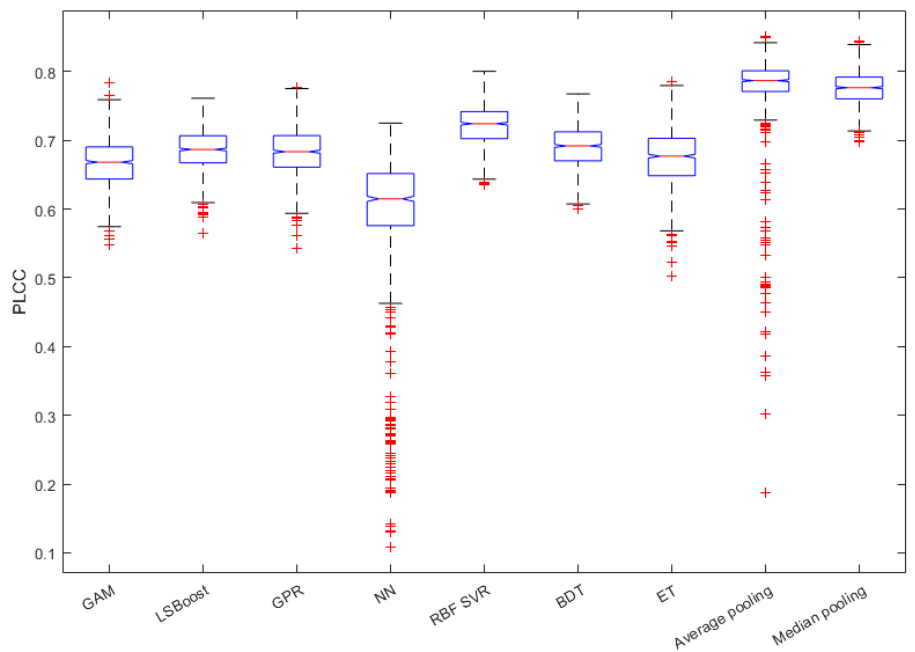
Figure 5. Box plots of PLCC values for different regression techniques and strategies. Measured over 1000 random training–testing splits on KoNViD-1k [16]. The bottom and top edges of each box correspond to the 25th and 75th percentiles, respectively. The whiskers continue to the most extreme data points that were not recognized as outliers, which are denoted by red ‘+’